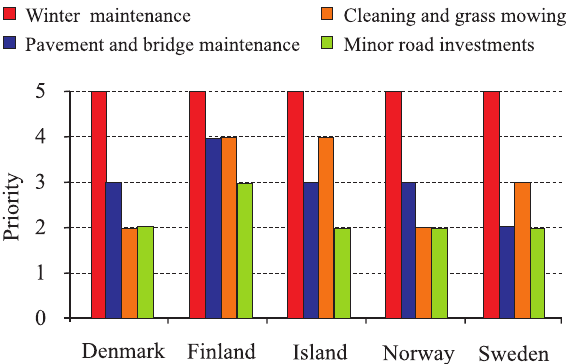
Fig. 1. Priority of the maintenance measures in case of maintenance funding gap in the Nordic countries (Gahm